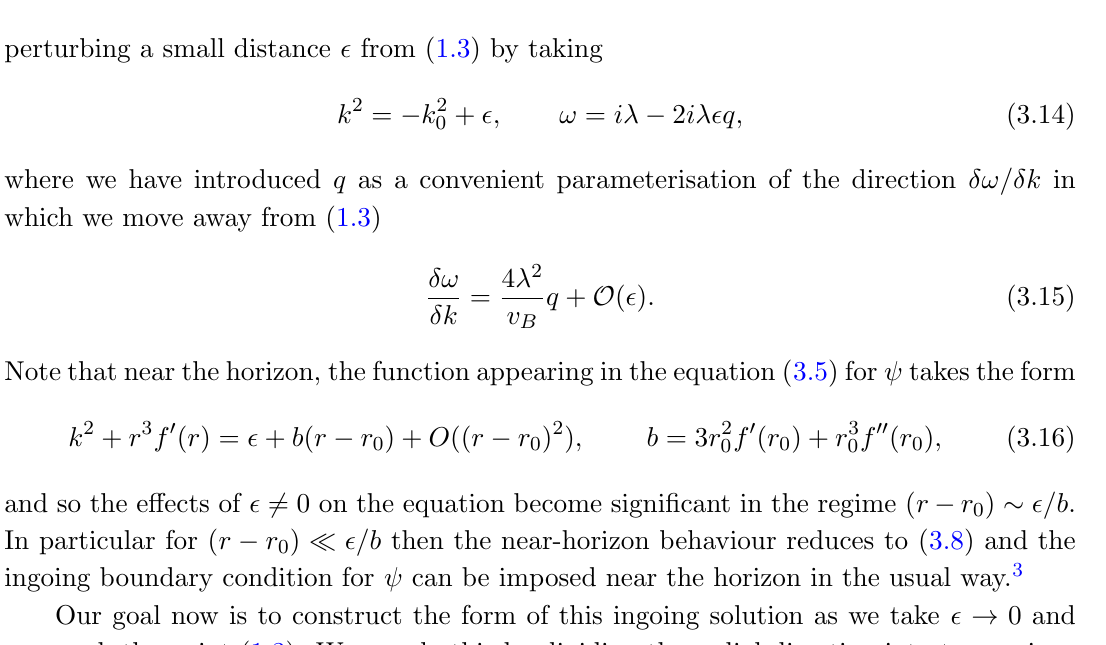
Figure 1 . Moving slightly away from (1.3) changes the near-horizon behaviour of . To calculate the Green’s function we solve separately for the solution in the UV region ( r region ( r r 0 ) (cid:15)=b . The solutions can then be matched by comparing them in their overlapping (cid:0) (cid:24) regime of